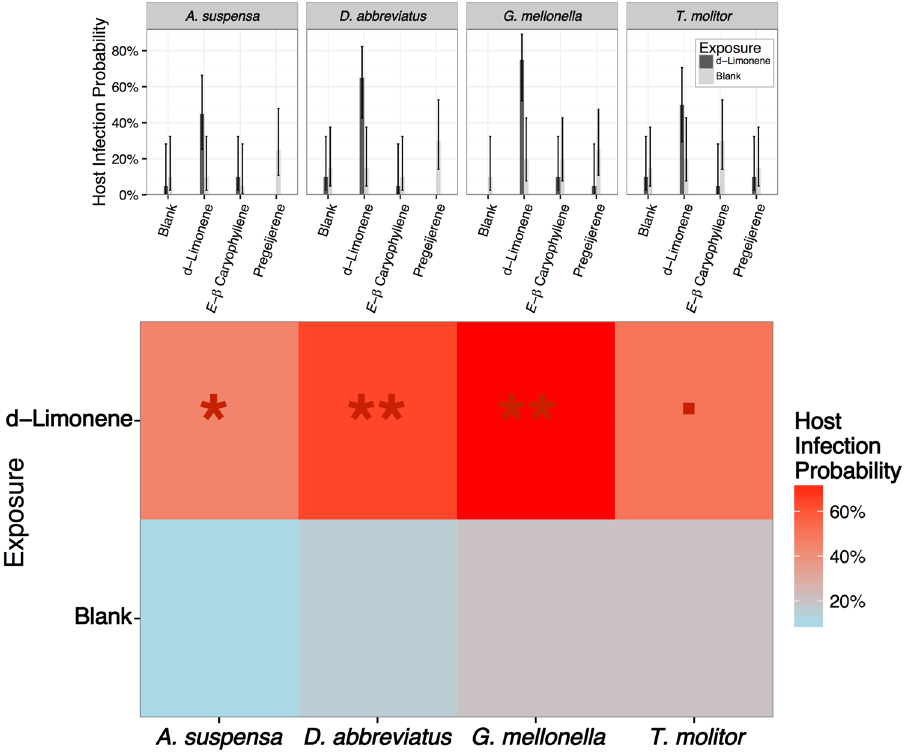
Figure 3. Parasitoid Learning Affects Alternate Host Infection. Prior exposure to d-limonene increases host infection probability for the natural host, D . abbreviatus , the host in which it is reared, G . mellonella , and the caribbean fruit fly A . suspensa . Cohorts of entomopathogenic nematode H . indica infective juveniles were exposed to blank controls or d-limonene then assayed in four-arm, sand-filled olfactometers where they responded to larvae paired with three common plant volatiles. Bars and error bars denote host infection probability and ninety-five percent confidence intervals respectively. Double asterisks denotes significant enhancement of infection probability at P < 0.01. A single asterisk denotes significant enhancement of infection probability at P < 0.05. A period denotes marginally significant enhancement of infection probability at P <